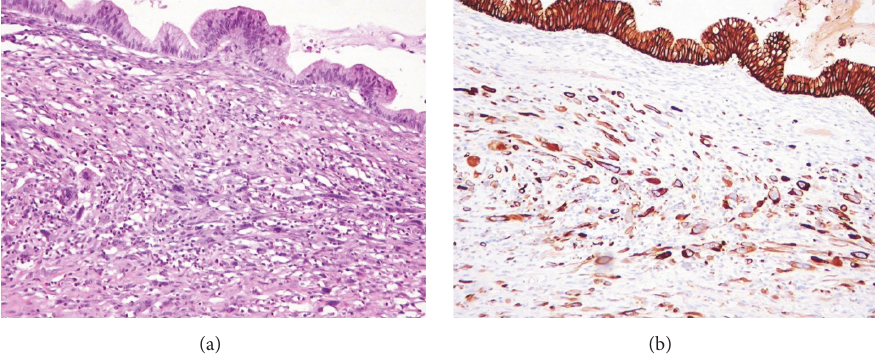
Figure 3: An undifferentiated carcinoma focus in mucinous tumor. (a) An infiltration of pleomorphic spindle-shaped cells beneath a mucinous borderline lining (H&E stain: × 100). (b) Diffuse immunoexpression of cytokeratin (cytokeratin [AE1/AE3] immunostain: ×